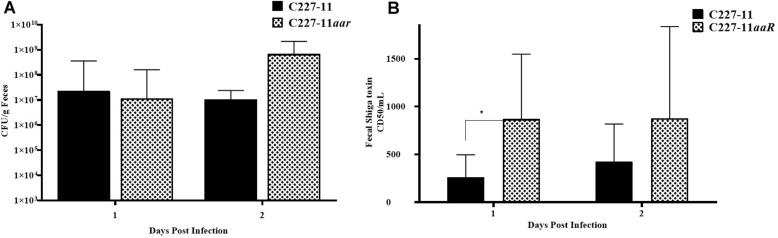
Colony forming units (CFU) per gram feces (A) and corresponding to Stx levels (B) after 1 or 2 days of infection by C227-11 and C227-11aar in Amp-treated C57BL/6 mice. The amount of Stx present, the 50% cytotoxicity dose (CD50) was determined by Vero cell assay. Each bar represents the geometric mean with geometric mean SD of eight mice. Differences between groups were determined by ANOVA multiple comparison with uncorrected Fisher’s LSD on log10 transformed cytotoxicity CD50 and colony count values; asterisks indicate sites that demonstrated a significant difference between mean colony count or Stx levels from days post-infection, *p < 0.05.